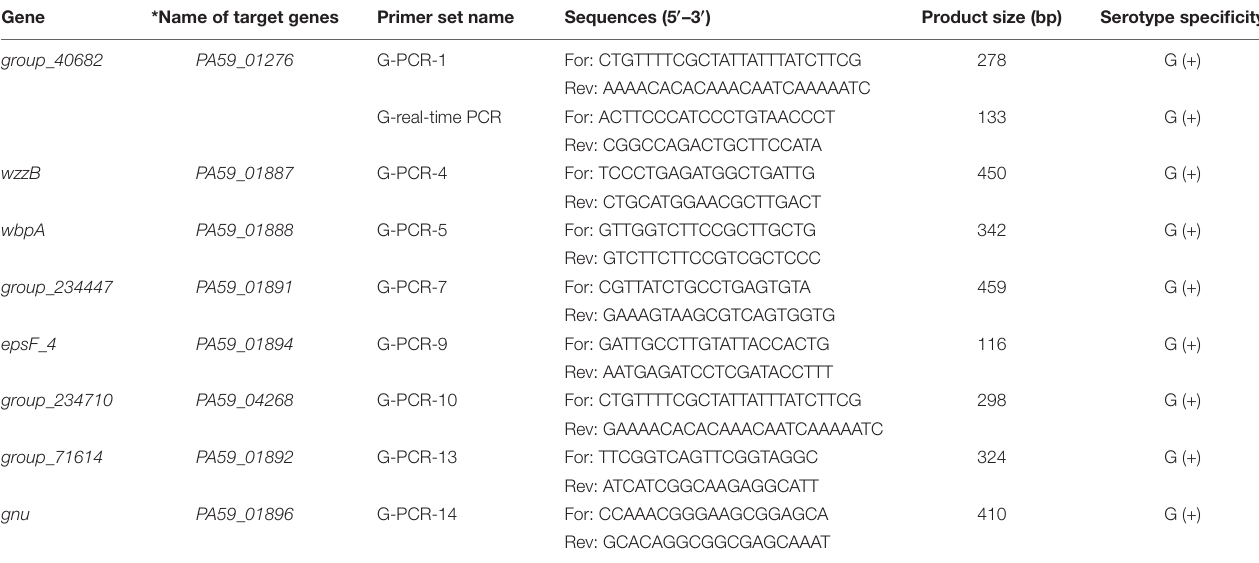
TABLE 2 | Specific target genes and primers are used for the detection of P. aeruginosa serogroup G. Gene *Name of target